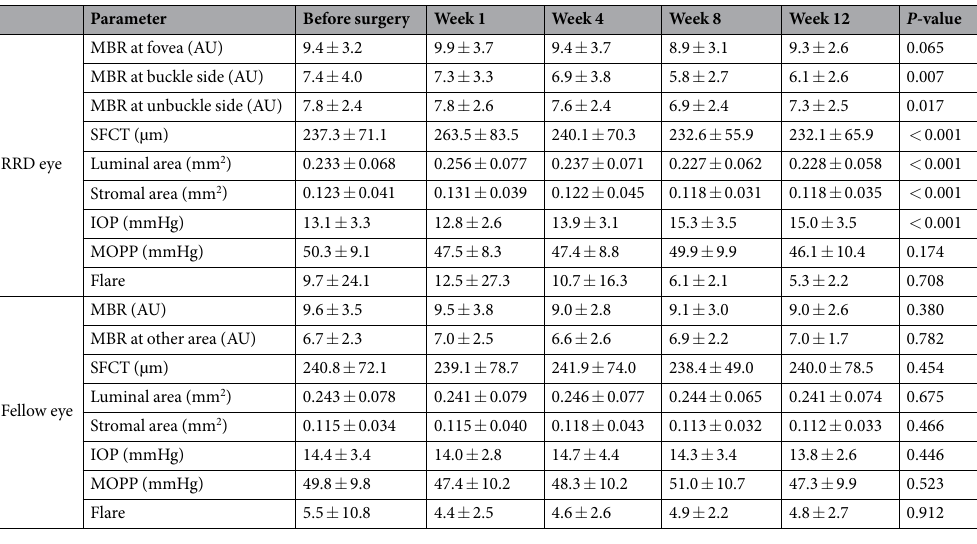
Table 2. Change in variable parameters with time. RRD: rhegmatogenous retinal detachment, MBR: mean blur rate, SFCT: subfoveal choroidal thickness, IOP: intraocular pressure, MOPP: mean ocular perfusion pressure.